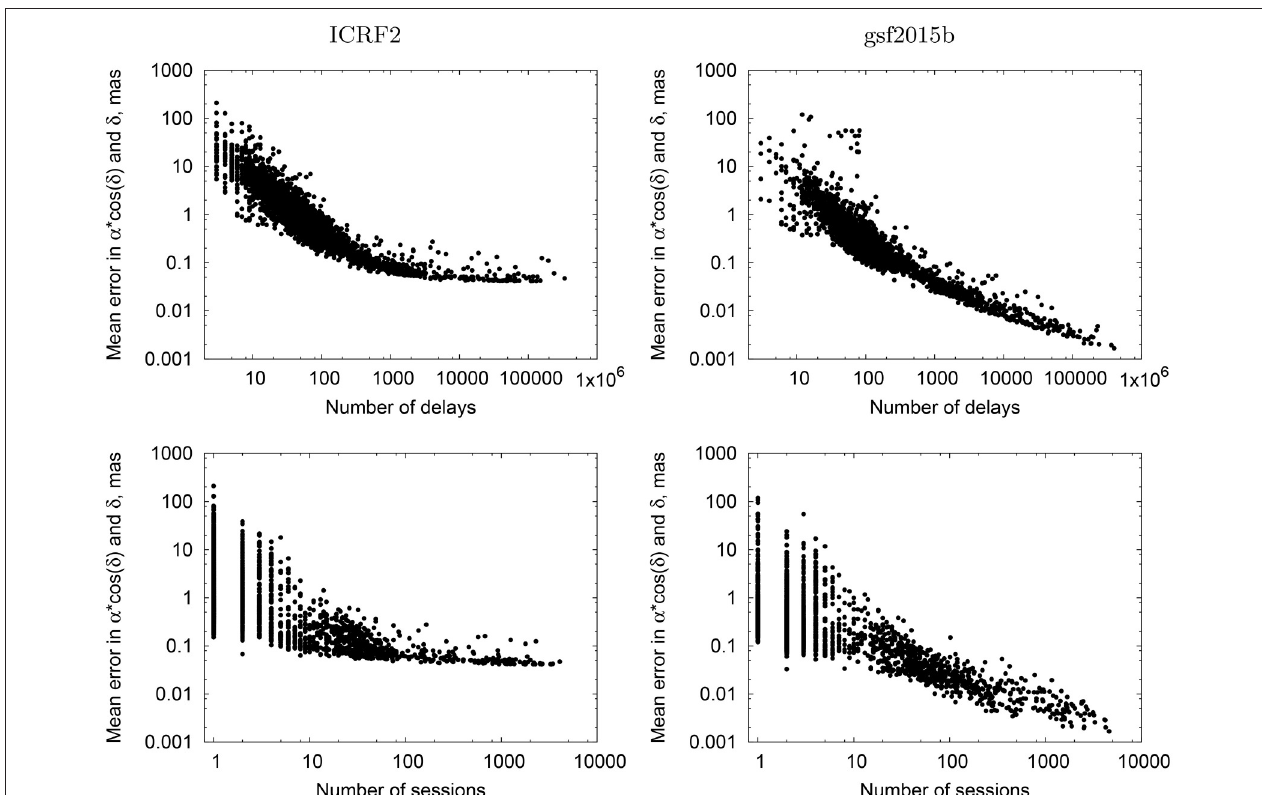
FIGURE 3 | Dependence of source position errors on the number of observations for the ICRF2 (left) and gsf2015b (right) catalogs.